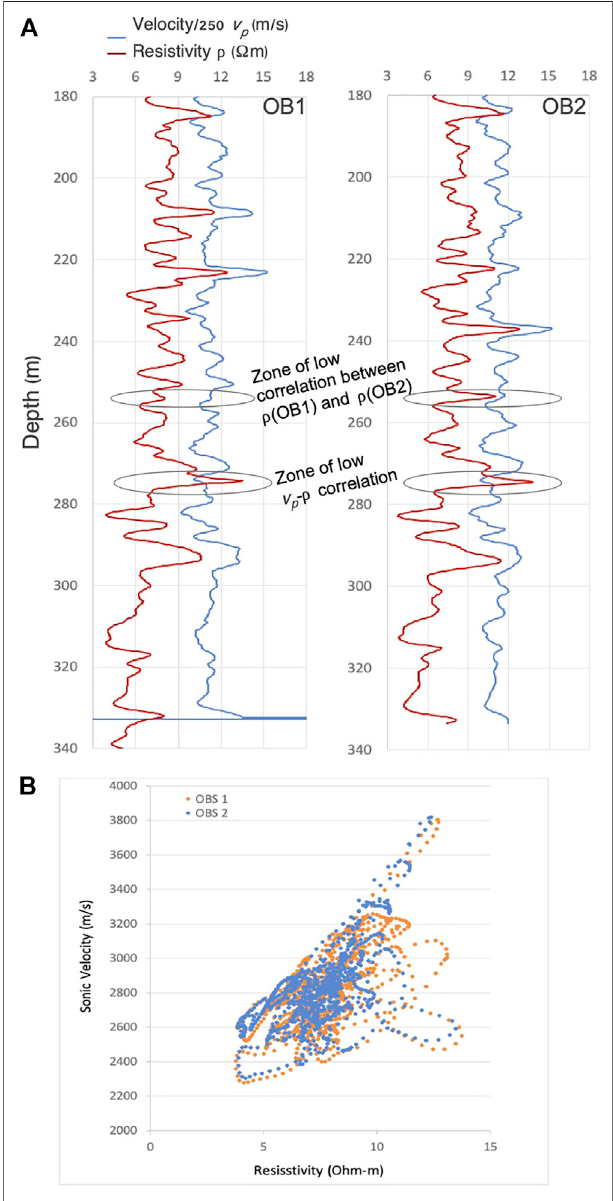
FIGURE2|(A) :PriorEMandseismicinformationatCaMI.FRS.Seismic- velocity ( v p ) logs (blue, scaled by a factor of 250) and resistivity ( ρ ) logs (red) weremeasuredinwellsOB1andOB2.Zonesoflowcorrelationareannotated only for depth sections that we consider as suf fi ciently resolved by the crosswell system. (B) : The cross plot between velocity and resistivity measurements highlights a relatively strong degree of correlation which is minimal in a narrow depth section between 270 m and 280